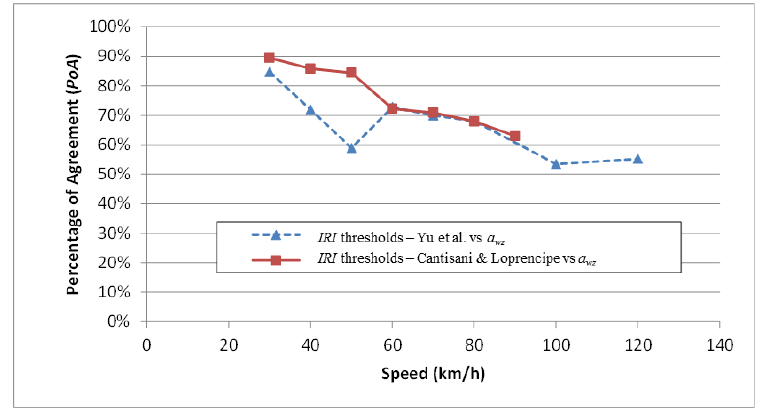
Figure 15. Percentage agreement between IRI thresholds suggested by Yu et al. [35] and Cantisani and Loprencipe [19] with ISO 2631 a wz .